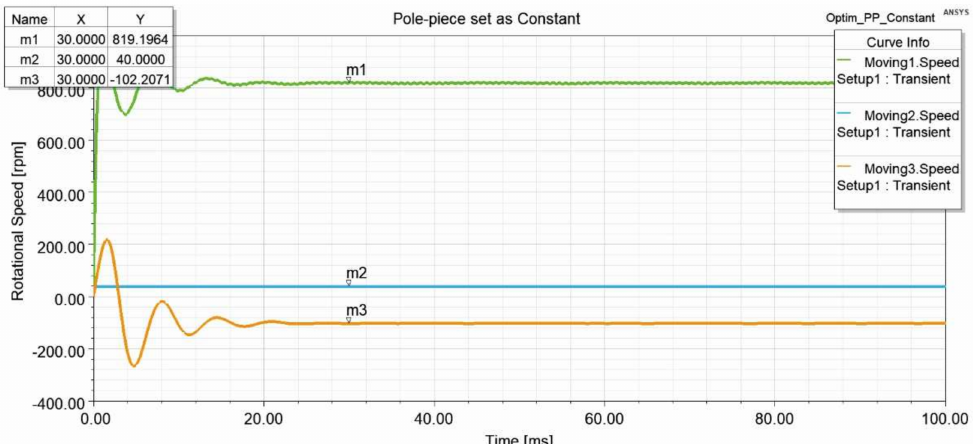
Figure 13. Rotational speed when the pole-piece set as